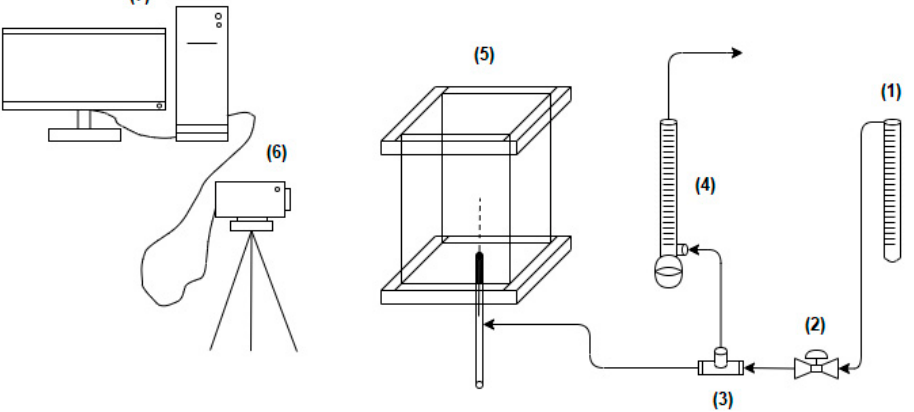
Figure 1. Experimental setup. (1) Gas flowmeter, (2) Valve, (3) Three-way valve, (4), Bubble flowmeter, (5) Plexiglass cell, (6) High-speed digital video camera, and (7) PC.